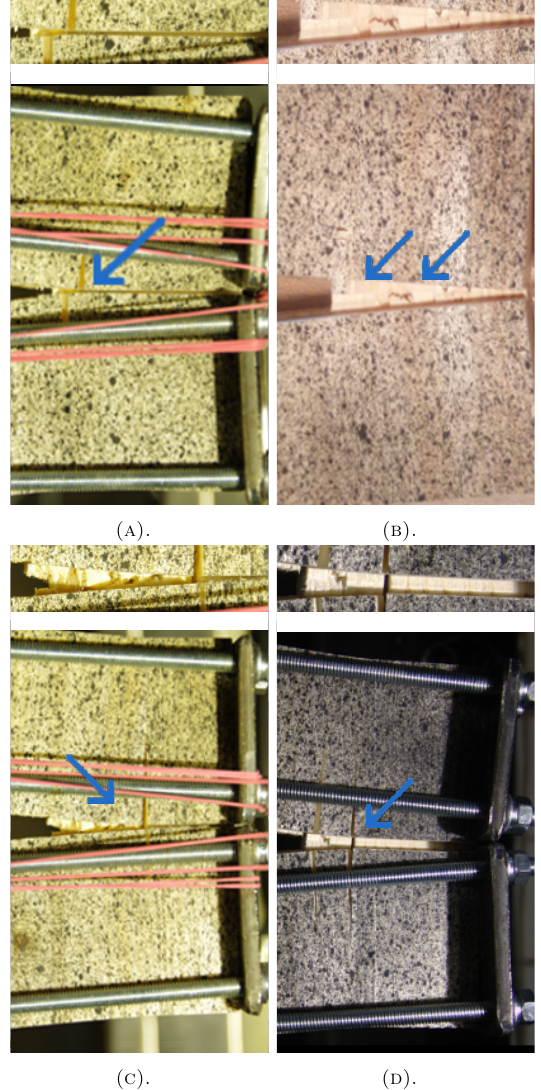
Figure 6. Failure of pre-stressed CT specimens with the load-grain angle of θ = 0°: (A) type F0 - disin- tegration parallel to the grain initiated at or around the notch tip, (B) type F1 - fibers’ rupture concen- trated around or at the cross-section ahead of the notch, (C) type F2-a - fibers’ rupture concentrated around or at the cross-section ahead of the notch followed by disintegration propagating from the cross- section’s middle, and (D) type F2-b - fibers’ rupture concentrated around or at the cross-section ahead of the notch accompanied by disintegration propagating from both the notch tip and the cross-section’s middle.